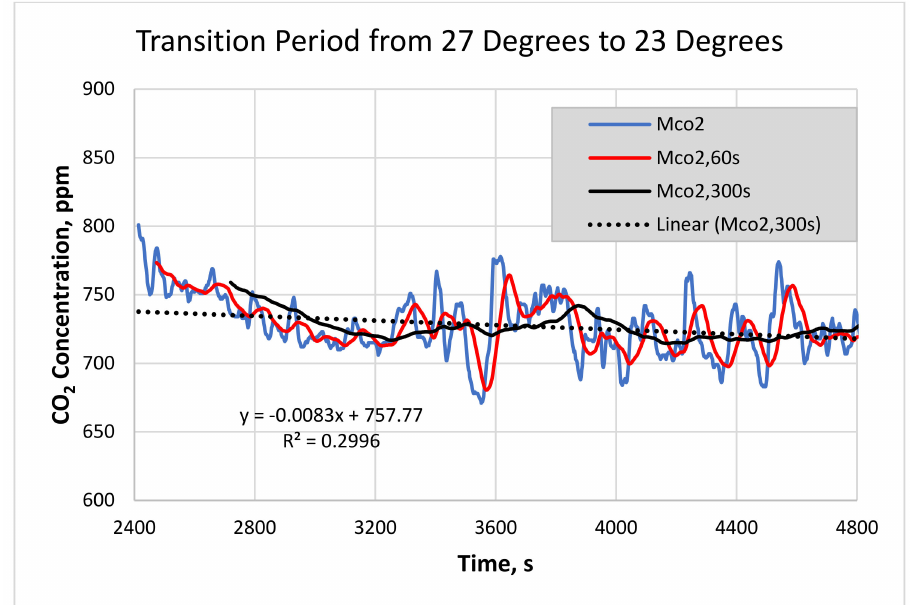
Figure 19. CO 2 concentration, exposure in the transition period from 27 ◦ C to 23 ◦ C: instanta- neous data Mco 2 (blue curve); evolution curve of the CO 2 concentration, time-averaged for 60 s, Mco 2,60s (red curve); and evolution curve of the CO 2 concentration, time-averaged for 300 s, Mco 2,300s (black